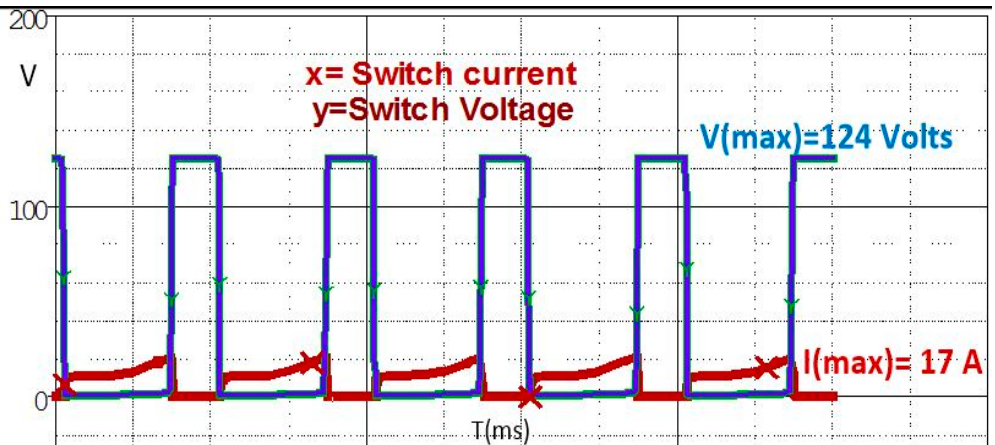
Figure 28. Voltage and current of switch “s” of the high-gain boost converter [7].